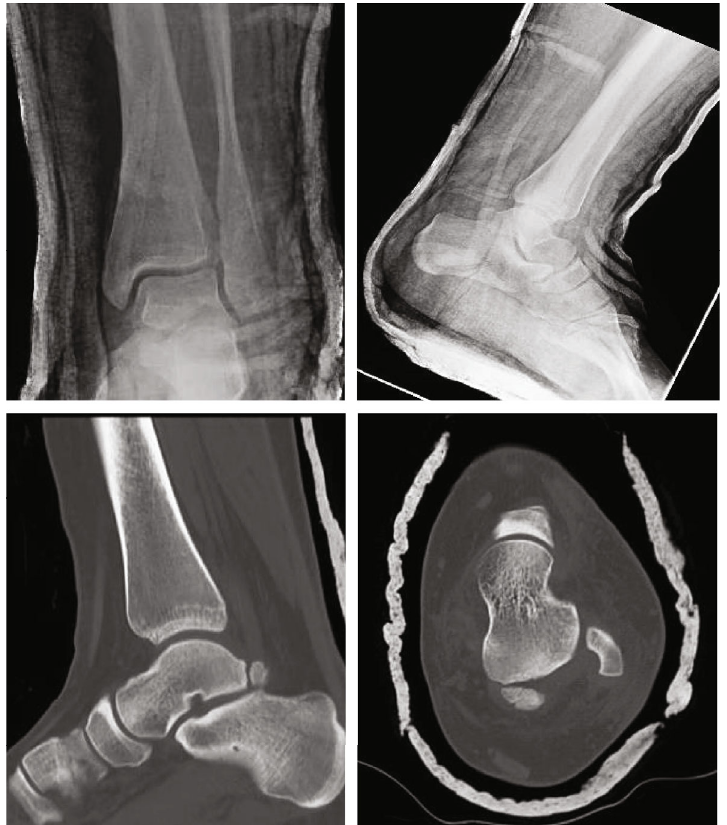
Figure 3: Mortise and lateral radiographs demonstrating reduced tibiotalar joint. Axial and lateral CT scans demonstrate displaced os trigonum without the fracture.